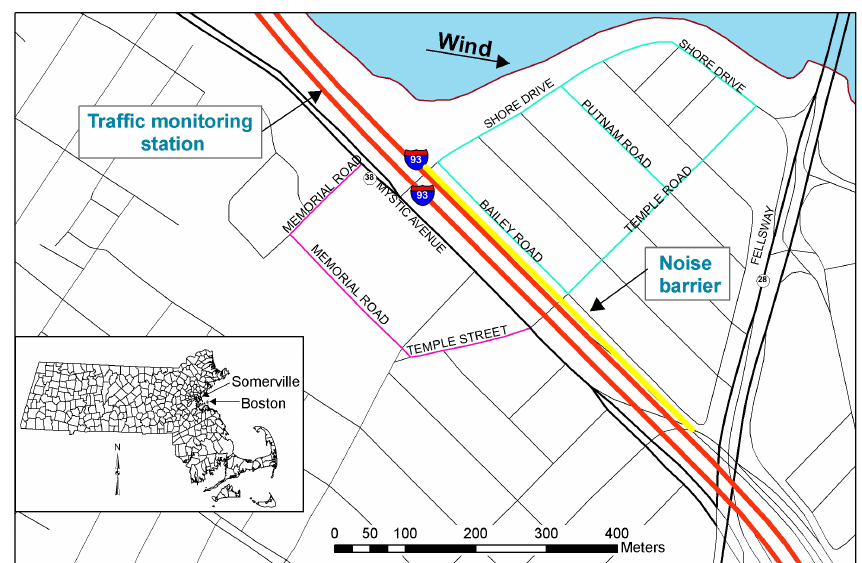
Fig. 1. Map of monitoring